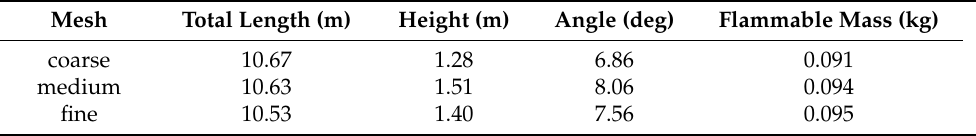
Table 1. The quantities of interest for the mesh refinement study are the plume downstream distance, height, angle from the floor, and the steady-state flammable mass. These were all simulated with a wind speed of 1.34 m/s and a pool diameter of 0.85